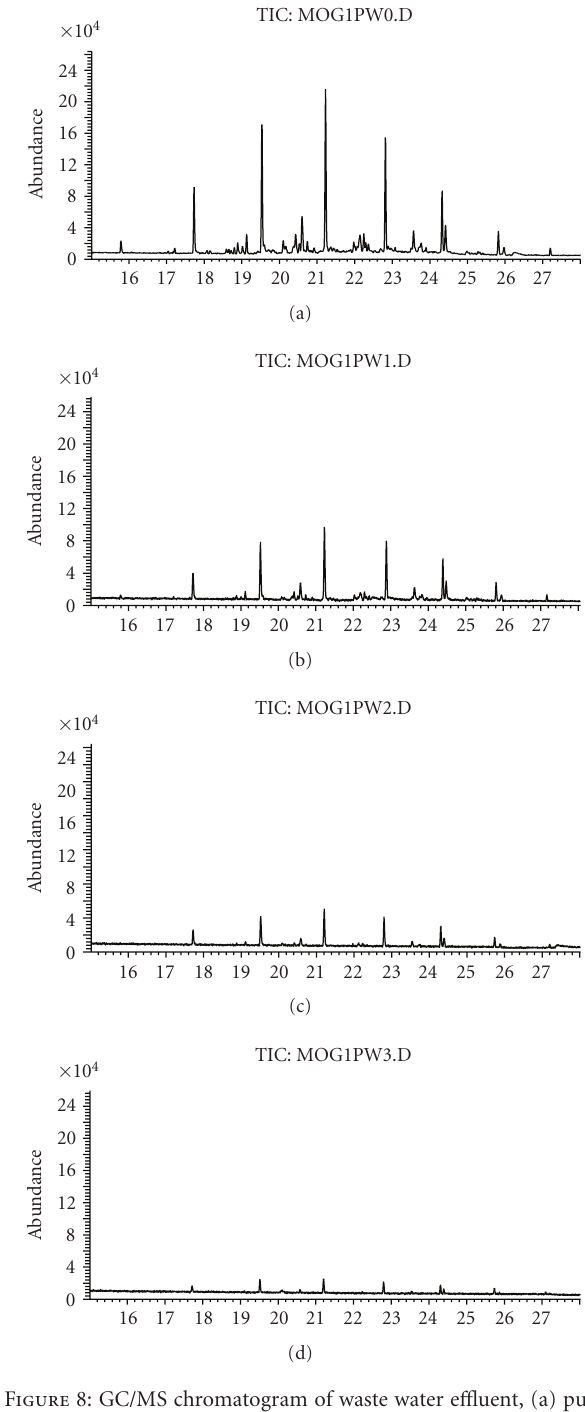
Figure 8: GC/MS chromatogram of waste water e ffl uent, (a) pure sample with no treatment, (b) 1st pass through drum reactor, (c) 2nd pass through drum reactor, and (d) 3rd pass through drum reactor (accumulative total) catalyst treatments over a 10-minute